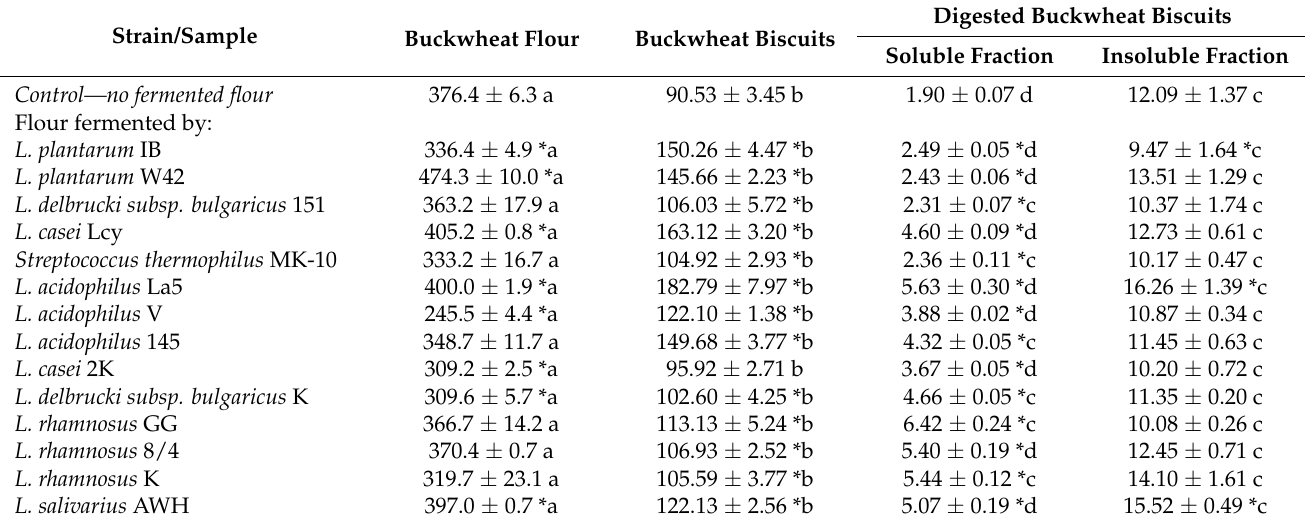
Table 1. The content of rutin (Ru) in fermented raw buckwheat flours and buckwheat biscuits before and after digestion in vitro ( µ g g − 1 d.m.).